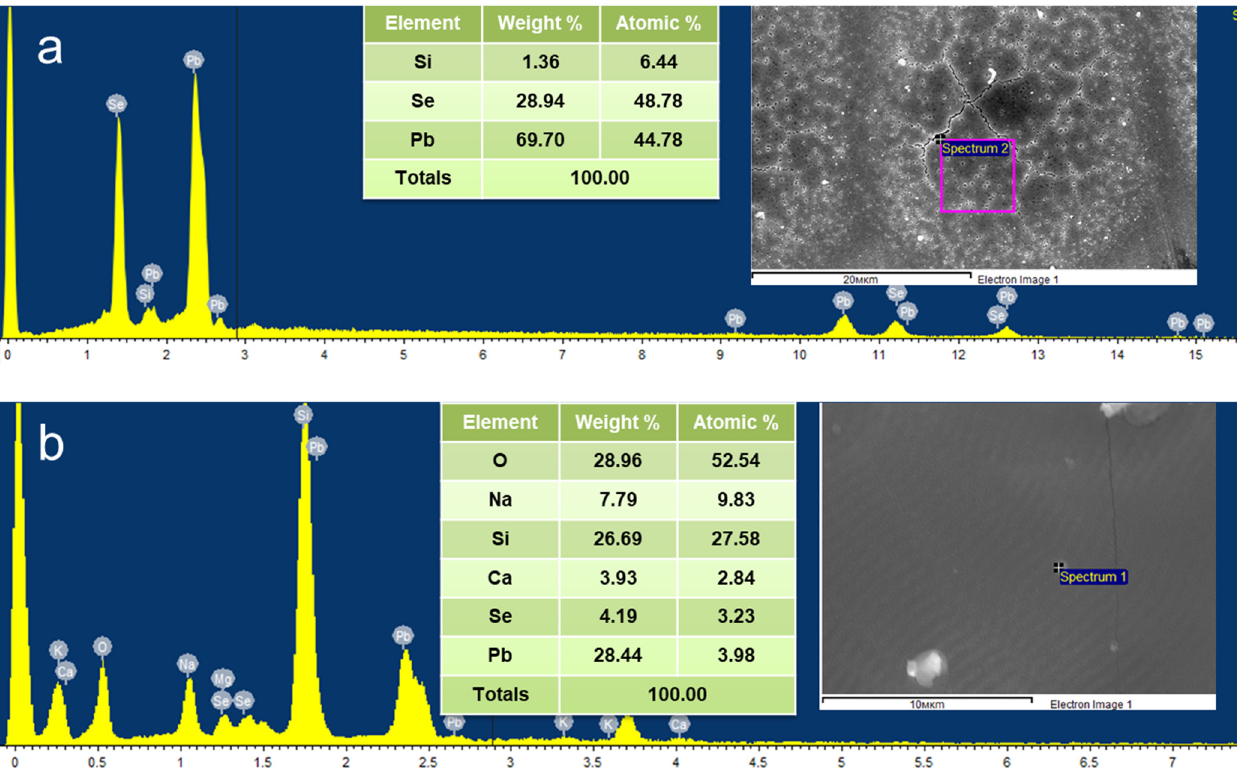
Figure 7. FESEM-EDX image: ( a ) darkening mode with pulsed radiation modification, ( b ) bleaching mode with pulsed radiation modification.